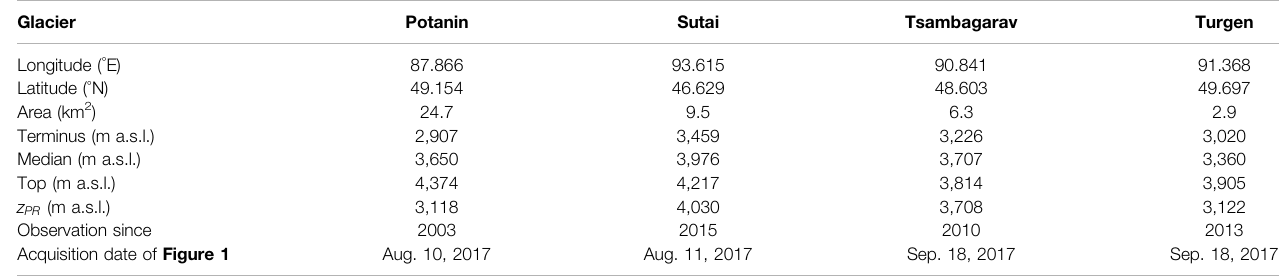
z PR denotes the reference elevation for calculating precipitation gradient.